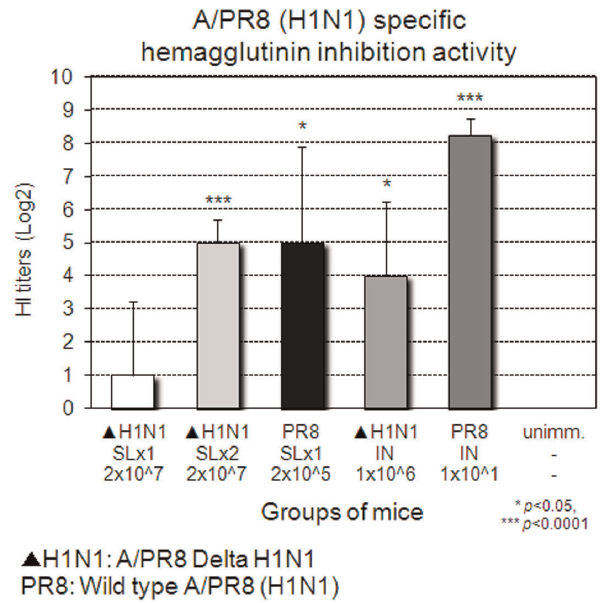
Figure 5. Induction of virus-specific Abs upon immunization with Delta H1N1. On the day before challenge as described in Figure 3, the sera were collected and the titers of virus-specific Abs were determined by A/PR8 virus-coated ELISA plates. The values represent the mean + SEM antibody titers of sera from 5 mice per